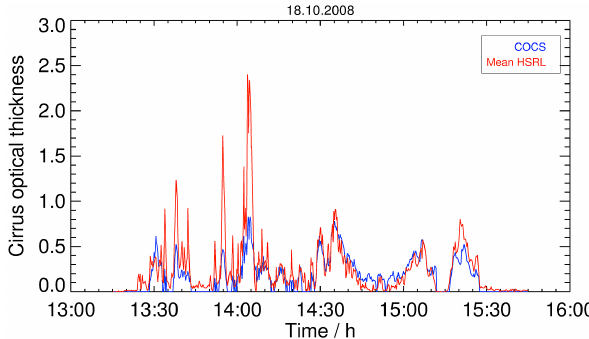
Figure 10. Cirrus optical thickness measured by COCS (blue) and by the HSRL (red) during the FALCON flight, 10 October